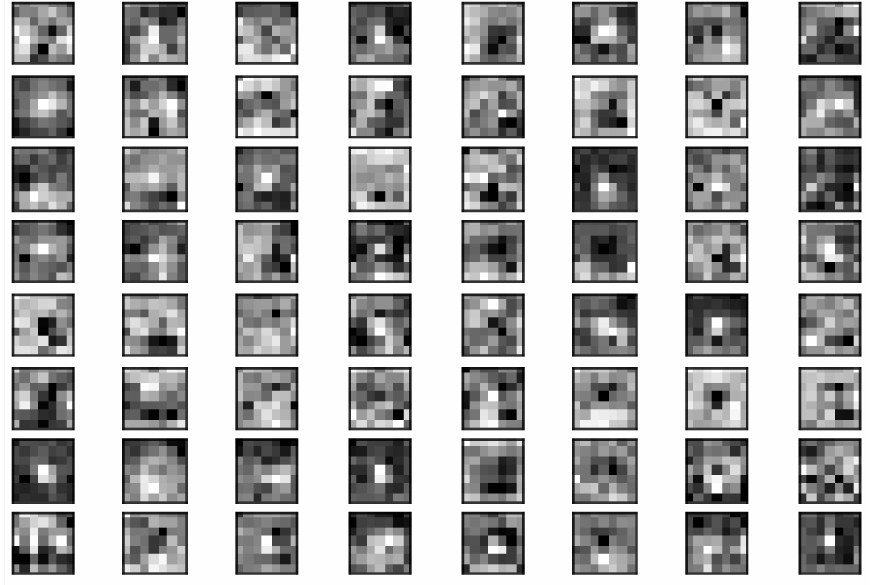
Figure 15. Feature map from Dense_Block4 of the DenseNet-121